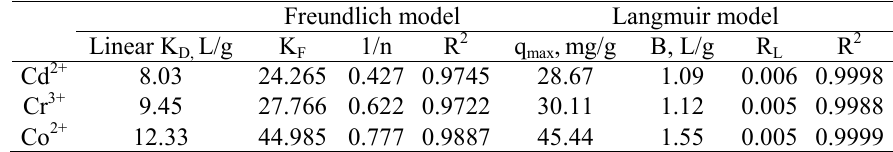
Table 3. Isotherm parameters of Cr 3+ , Cd 2+ , and Co 2+ adsorption on activated carbon from orange peel.